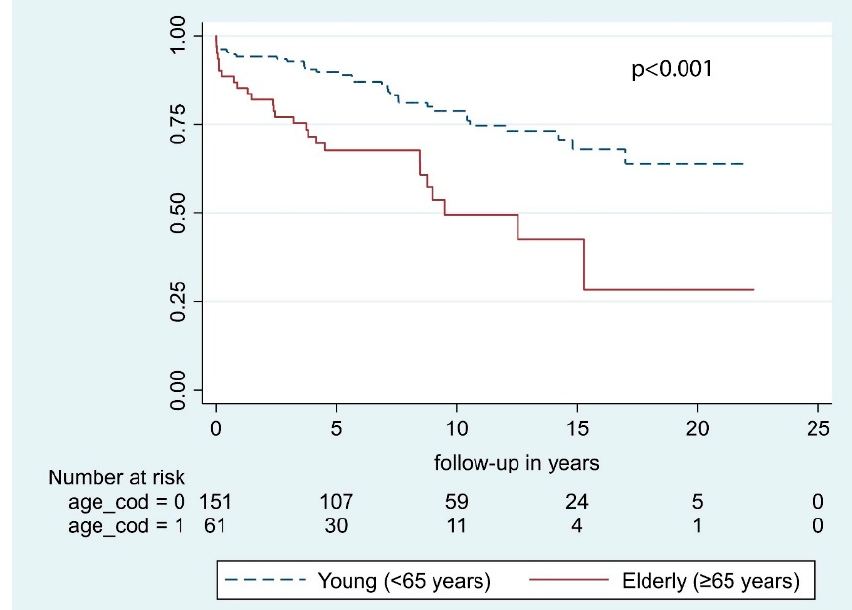
Figure 2. Overall survival by age at primary surgery.